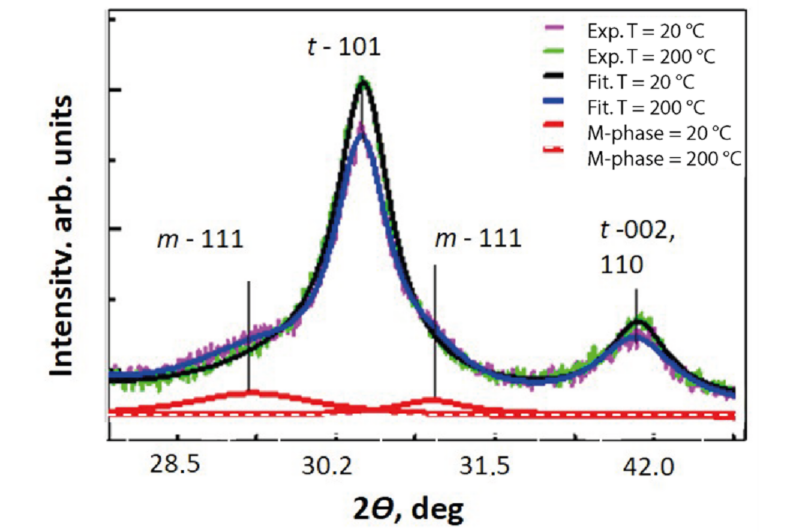
Figure 3. Experimental (green and purple lines) and calculated (green and black lines) XRD diffraction patterns, and mathematically selected M-phase signal (red lines) of ZrO 2 + 3 mol% Y 2 O 3 nanopowder sample, after saturation and drying at 200 ◦ C, 30